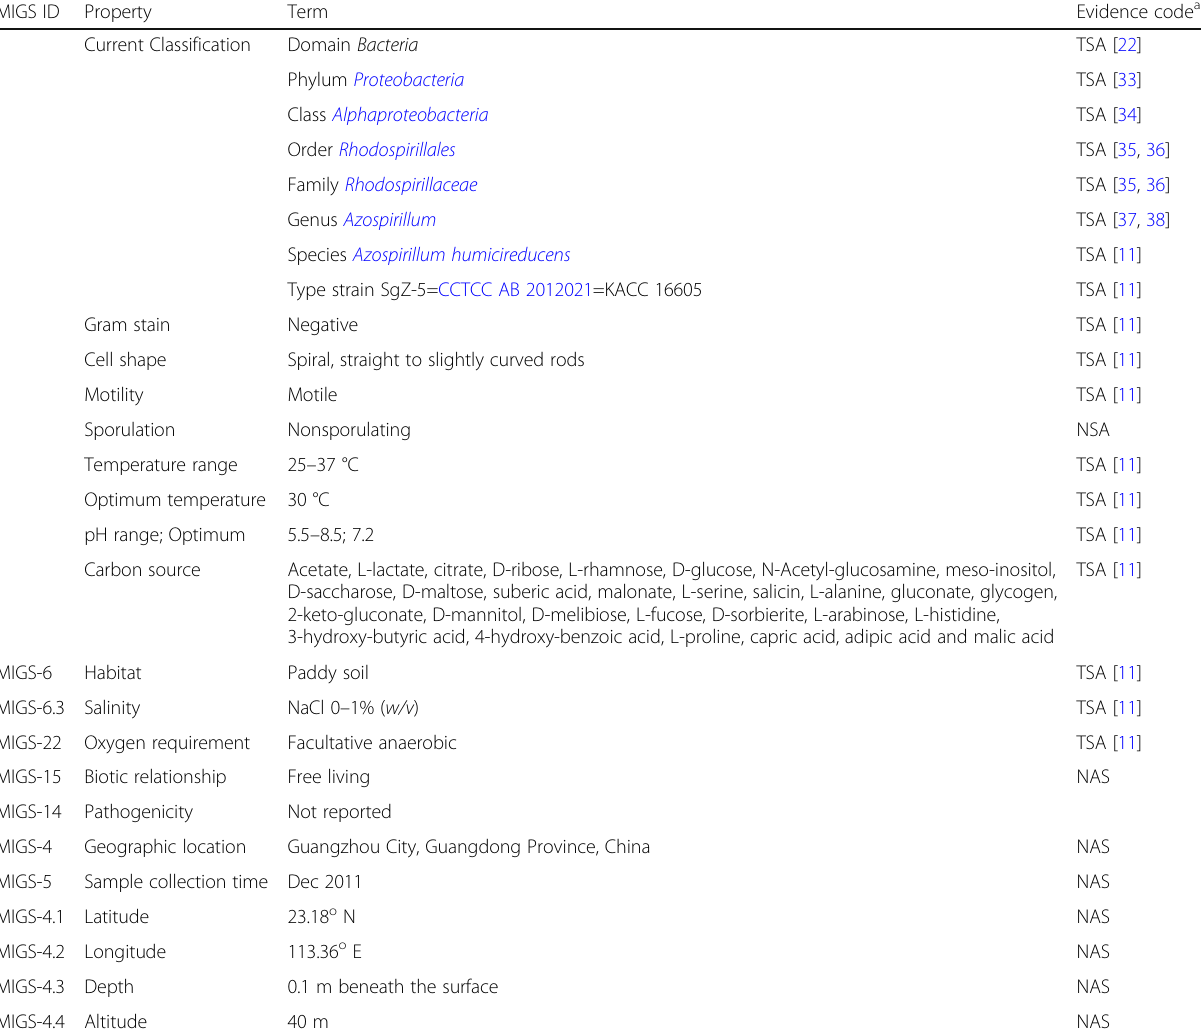
Table 1 Classification and general features of A. humicireducens SgZ-5 T according to the MIGS recommendations [16] MIGS ID